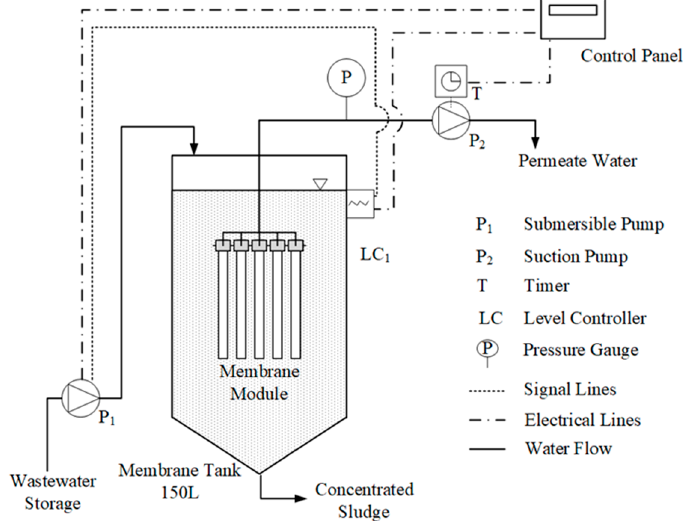
Figure 1. Schematic of the woven-fiber microfiltration (WFMF)